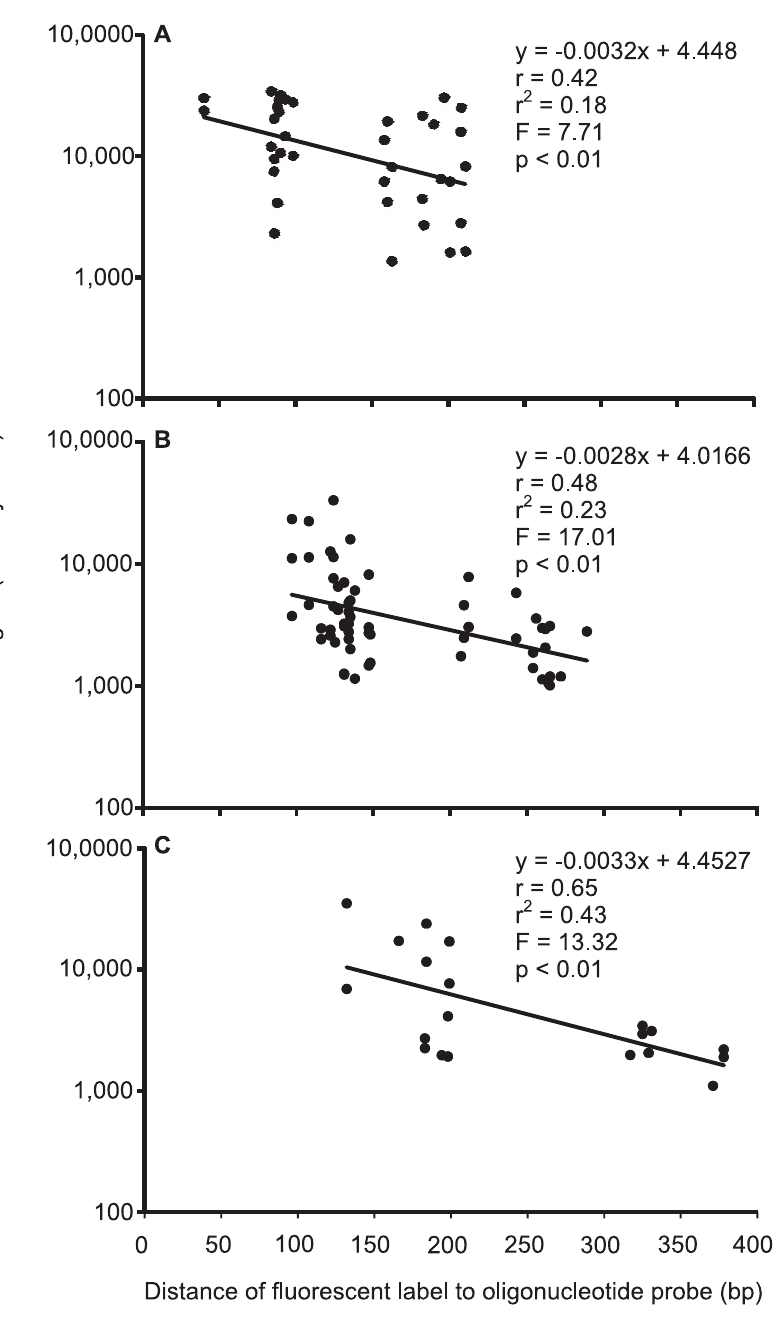
Figure 7. Position of label effect. Relationship of signal intensity and distance of fluorescent label to oligonucleotide probes based on partial sequences of mitochondrial (A) 16S rRNA, (B) cytochrome b , and (C) cytochrome oxidase subunit I genes of fishes from European seas.